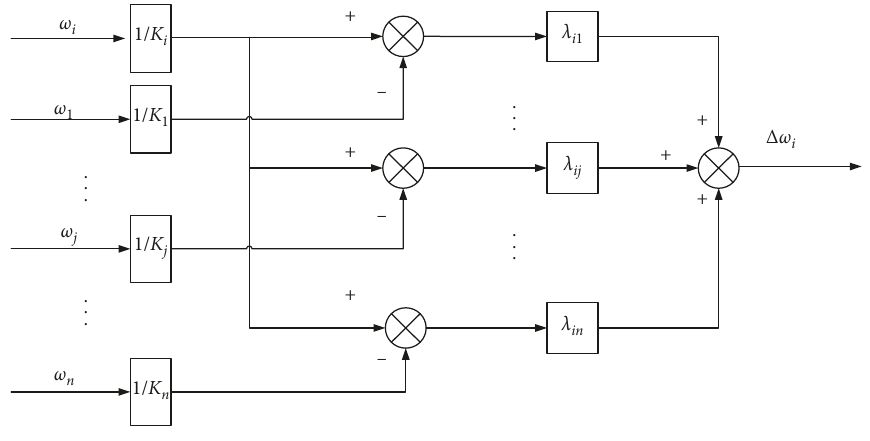
Figure 2: Velocity compensator structure based on fixed